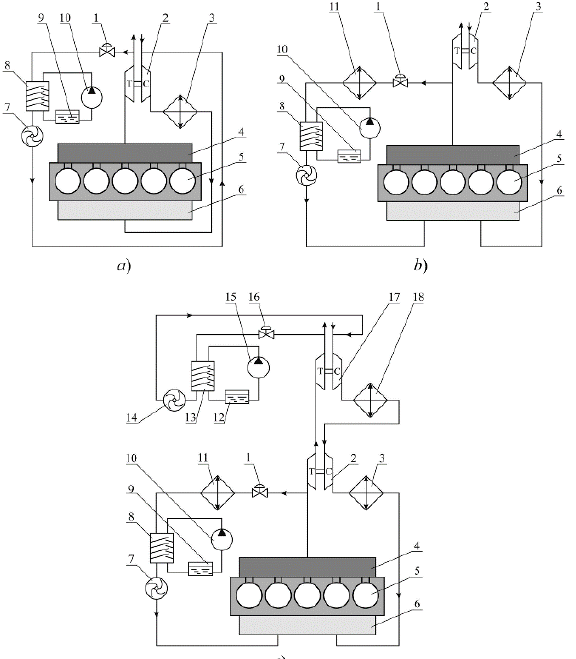
Figure 4. This is a figure. Schemes follow the same formatting. Schematic diagrams of the exhaust gas recirculation system ( a )—low pressure; ( b )—high pressure; ( c )—combined: 1, 16—control valve of the exhaust gas recirculation system; 2, 17—turbocharger; 3, 11, 18—air cooler; 4—gas exhaust manifold; 5—diesel; 6—air (purge) receiver; 7, 14—gas supercharger with electric drive; 8, 13— scrubber; 9, 12—freshwater tank; 10, 15—fresh water pump; T, C—gas turbine and air compressor of the